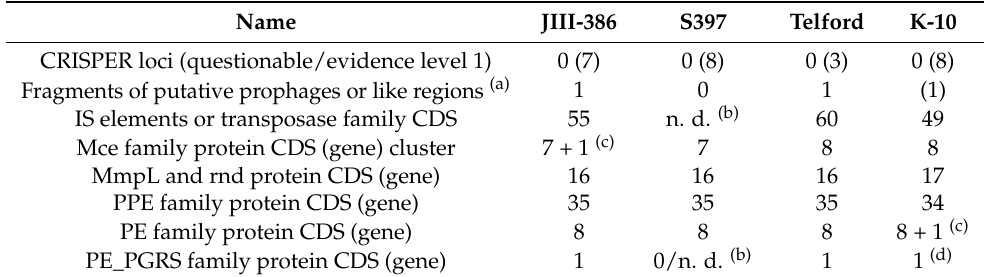
Table 4. Number of specific elements in different MAP genomes.